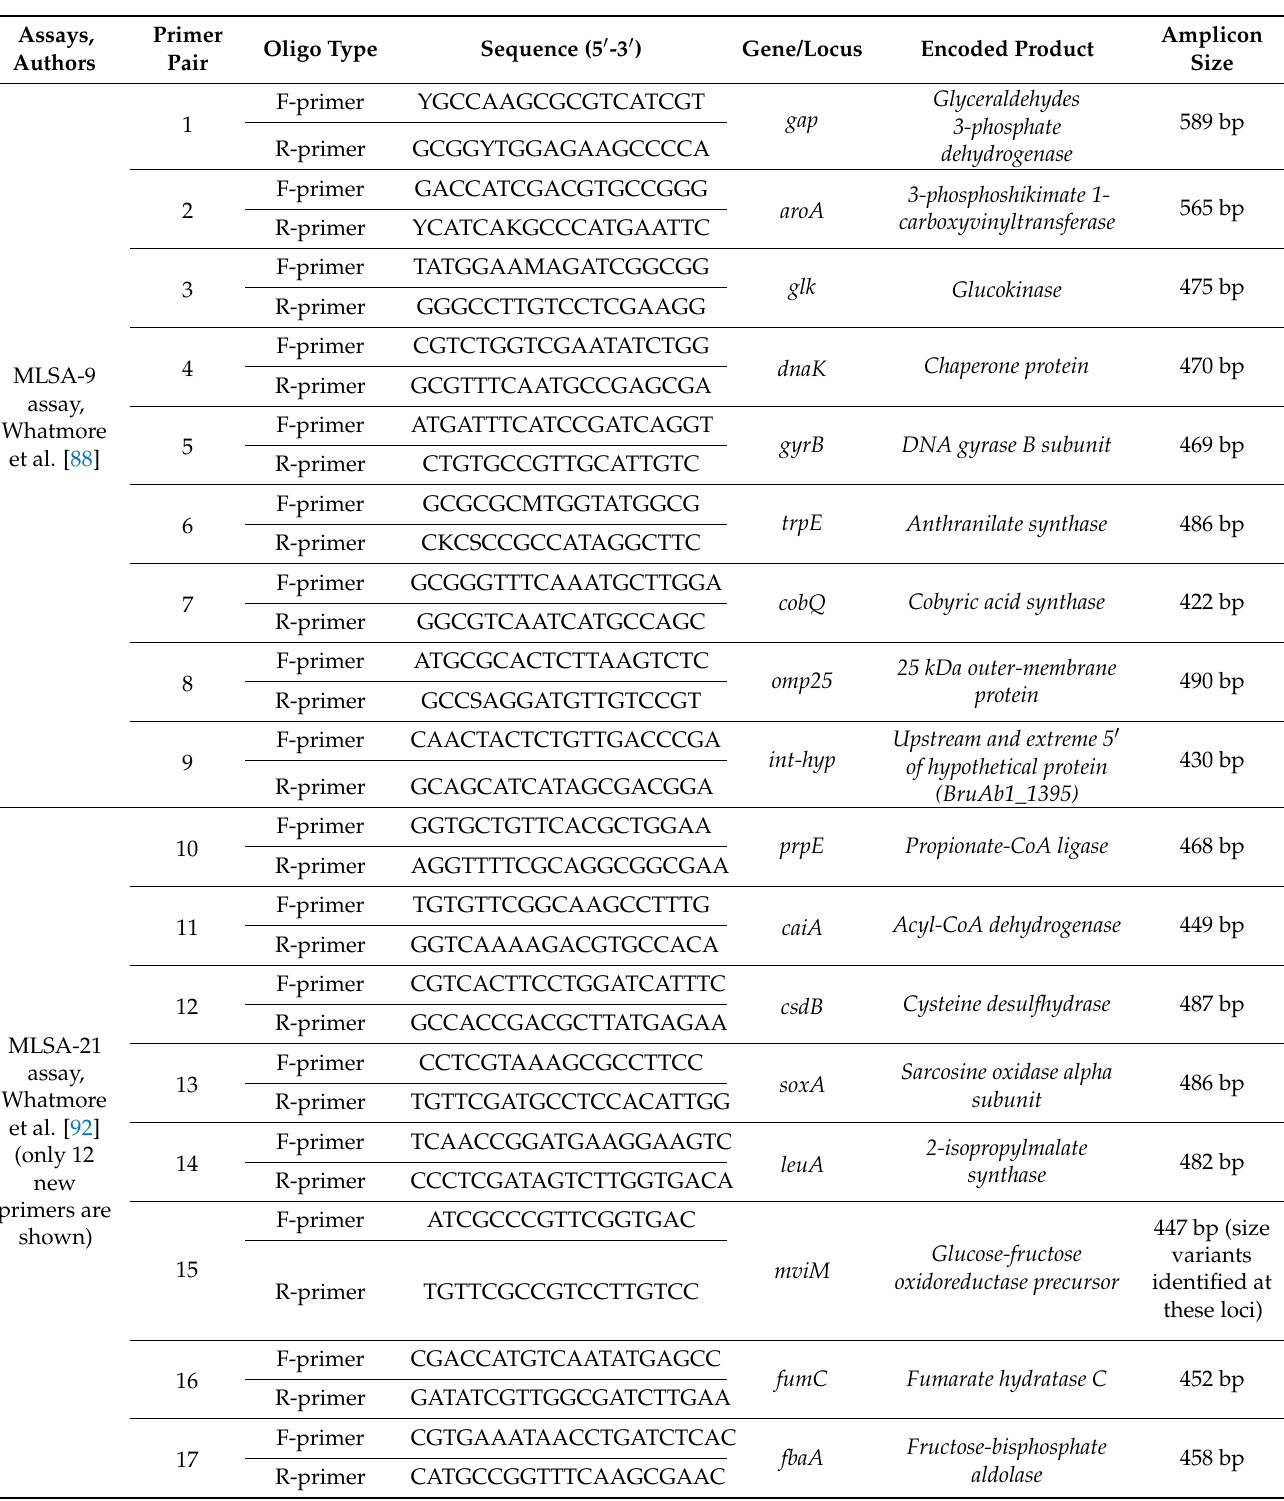
Table 4. Primers from the reviewed MLSA